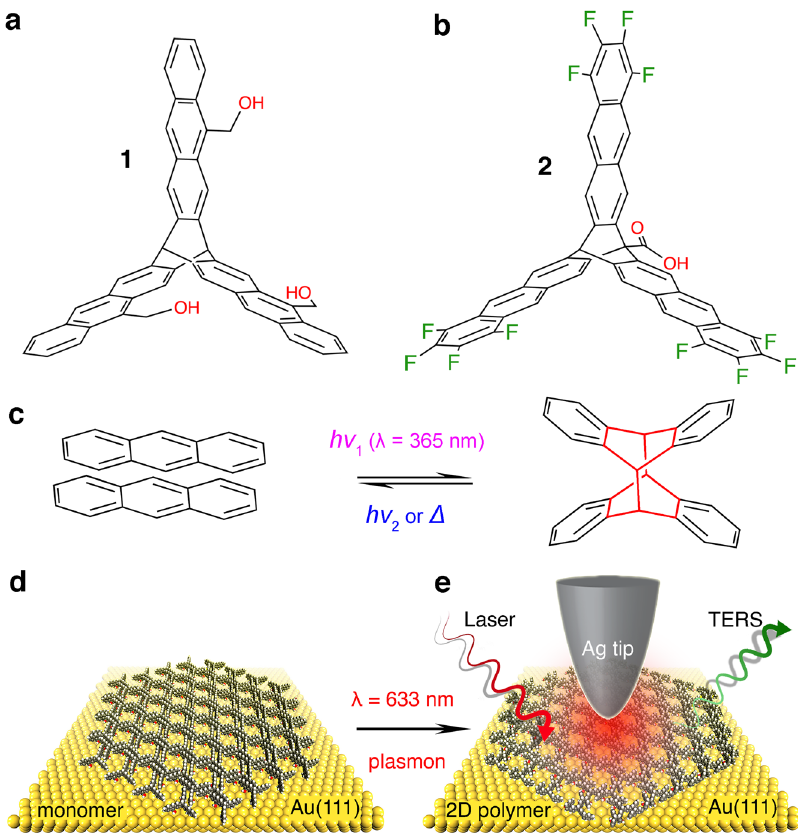
Fig. 1 UV-driven and plasmon-induced [4 + 4]-cycloaddition. a , b Chemical structure of monomers 1 and 2 , respectively. c The reversible photochemical reaction between two anthracenes. The [4 + 4]-photocycloaddition reaction can be triggered by UV laser irradiation (365 nm, ca. 3.40 eV) and can also be reversed by irradiation at shorter wavelengths or thermally. d Schematic illustration of the monomer ML on Au(111). e Schematic illustration of the TERS imaging for the plasmon-induced 2DP ML under visible laser irradiation (633 nm, ca. 1.96 eV). λ , wavelength. h ν laser light. Δ